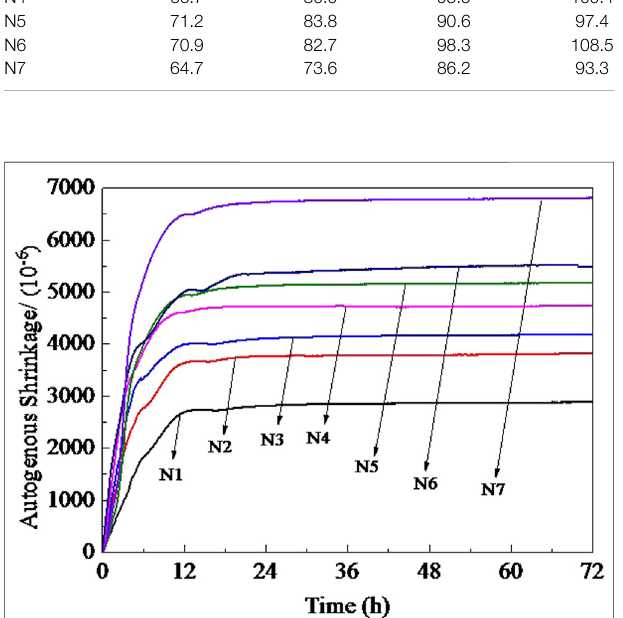
FIGURE 6 | Effect of M-PCE on auto-shrinkage of